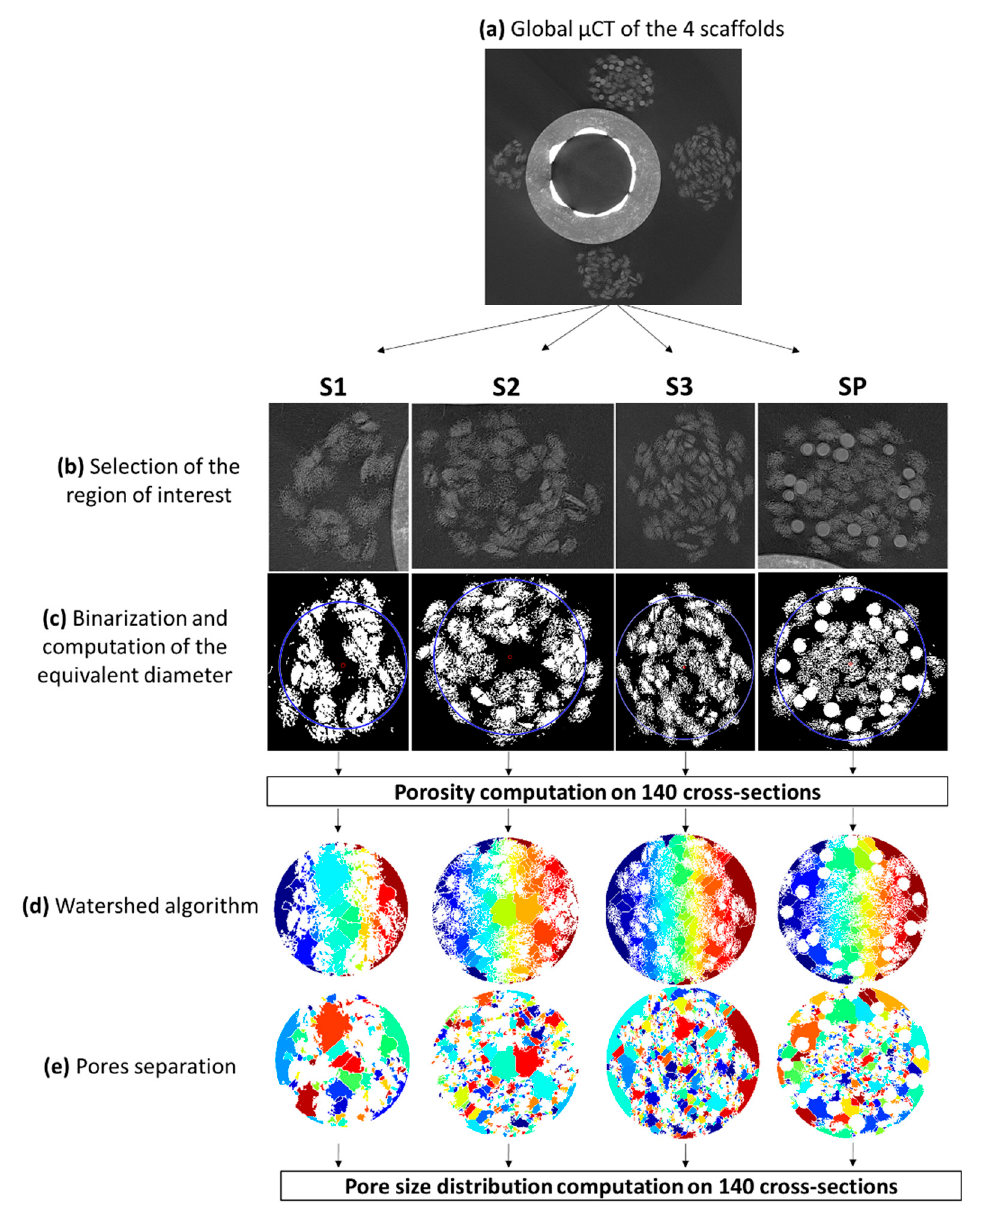
Figure 1. Image processing routine for post-treatment of µCT cross-sections for the four scaffold configurations (S1: one-layer silk scaffold; S2: two-layer silk scaffold; S3: three-layer silk scaffold; SP: silk/PLCL composite scaffold).